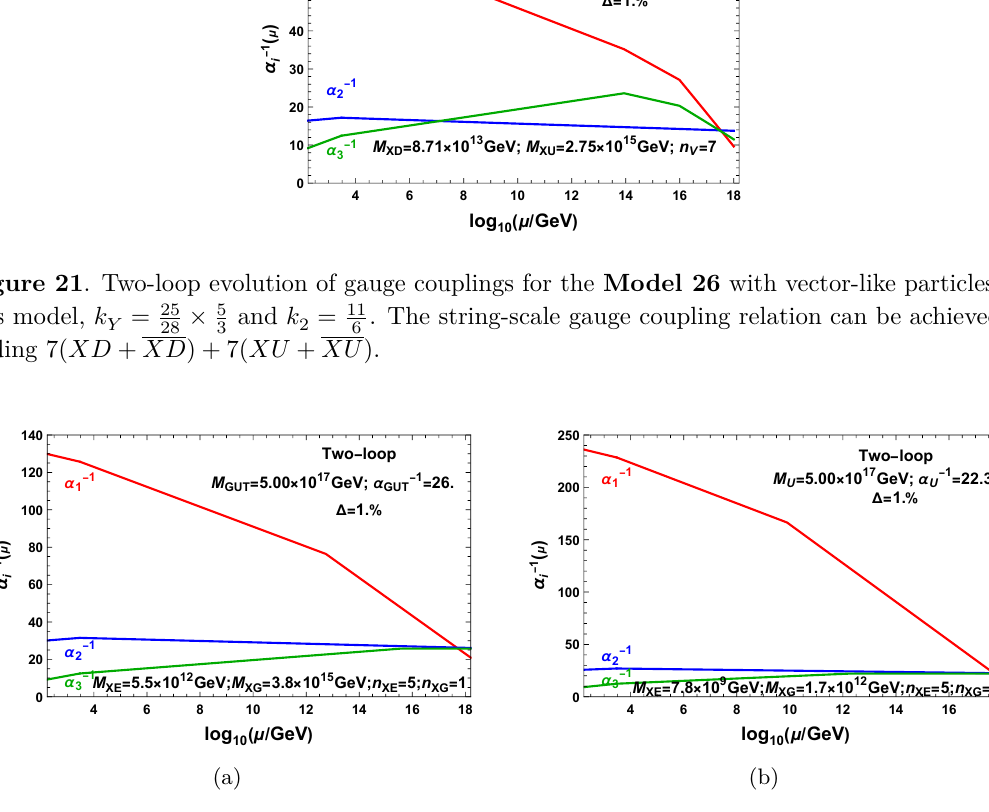
Figure 22 . Two-loop evolution of gauge couplings for the Model 28 (a) and Model29 (b) with vector-like particles. The string-scale gauge coupling relation can be achieved by adding 5( XE + XE ) + XG